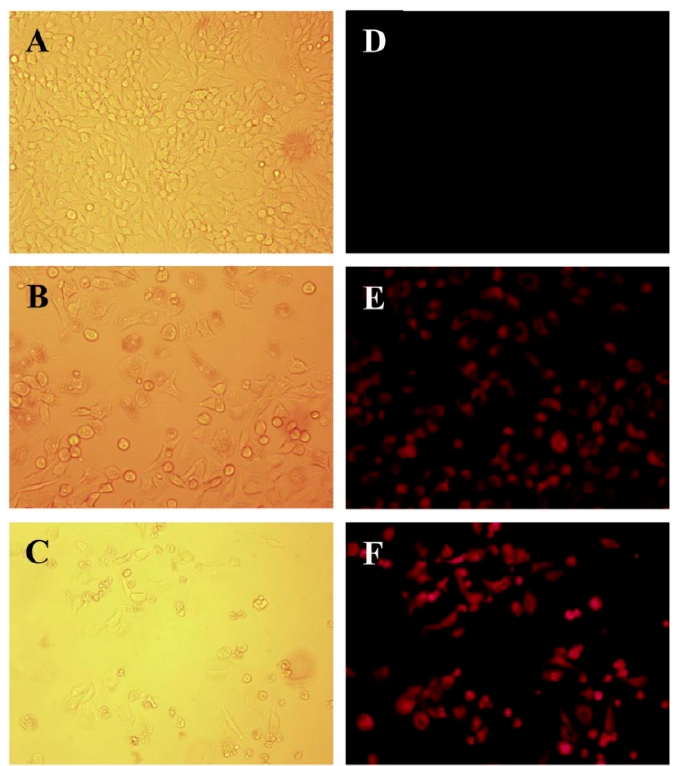
Figure 5. Microscopic images of cellular uptake in A549 cells, Bright field (left panel, A–C) and Fluorescence images (Right panel, D–F) of ( A , D ) untreated cells, ( B , E ) free EPI ‐ PTX, and ( C , F ) PLGA ‐ PEI ‐ EPI ‐ PTX NPs respectively.